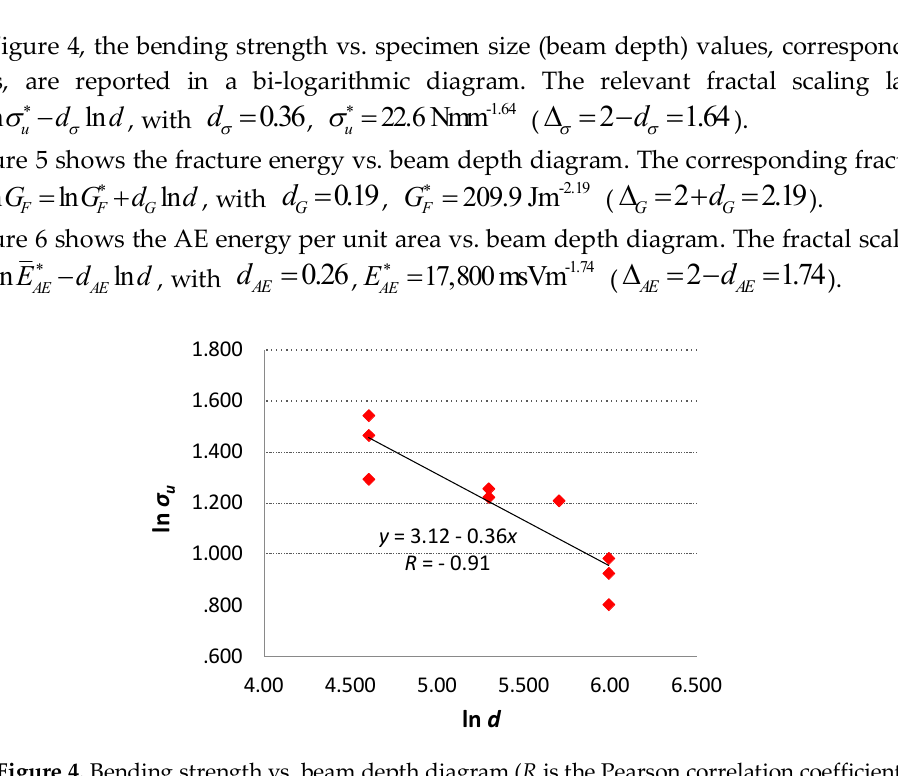
Figure 4. Bending strength vs. beam depth diagram ( R is the Pearson correlation coefficient).